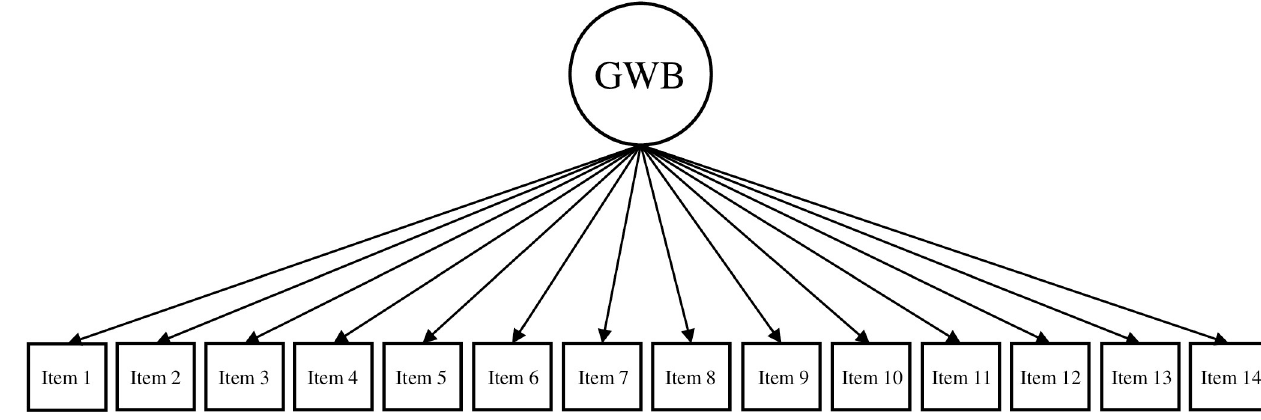
Fig 1. Single-factor model of the MHC-SF. Note . GWB = general well-being.